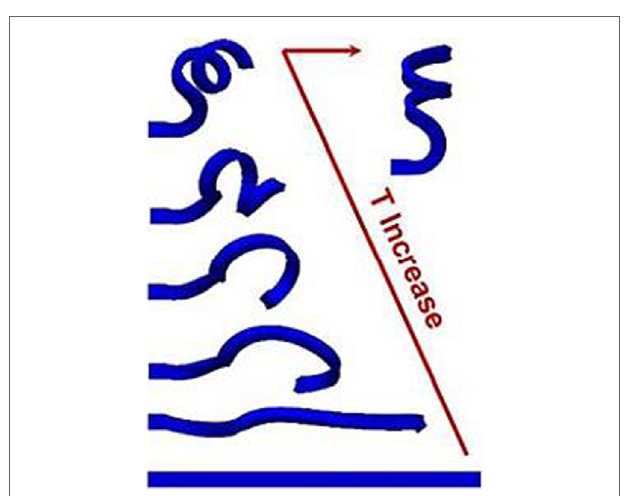
FigUre 6 | Finite element simulation of shape evolution of an lce beam on heating . Left 30% of beam has splayed nematic director, which induces a C-shaped bend, while the remaining beam has a 90° director twist through the thickness, giving rise to a helical twist.